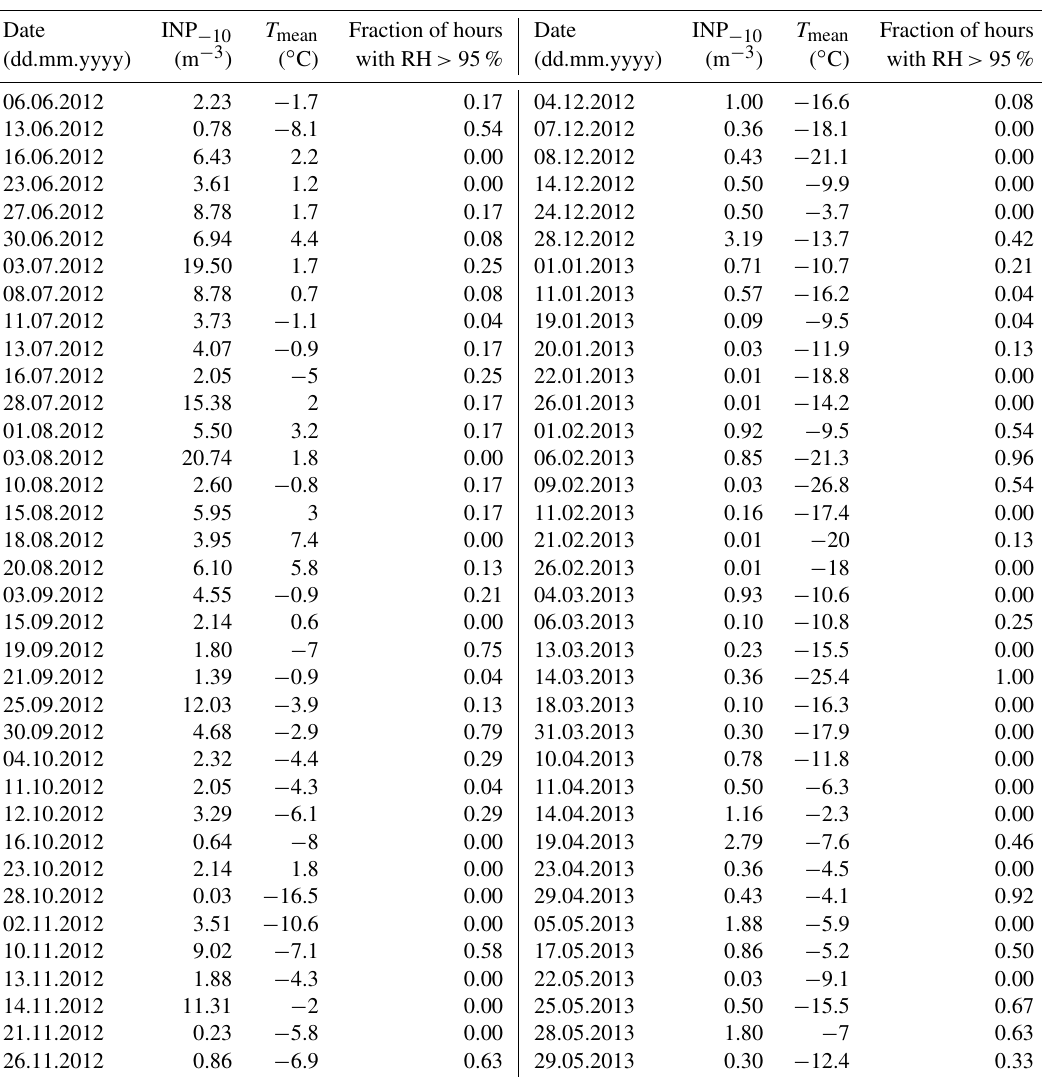
Table A2. Number concentration of ice-nucleating particles active at − 10 ◦ C (INP − 10 ) at Jungfraujoch, determined from randomly selected PM 10 filter samples. Each sample was collected throughout a full calender day, for which the local mean air temperature and the fraction of hours with relative humidity above 95% are shown. The INP data are from the study by Conen et al. (2015), and meteorological data are from MeteoSwiss. Assays of INPs that showed no freezing at all at − 10 ◦ C were set to a value of 0.01INP − 10 m − 3 to be displayable on the log scale in Fig.